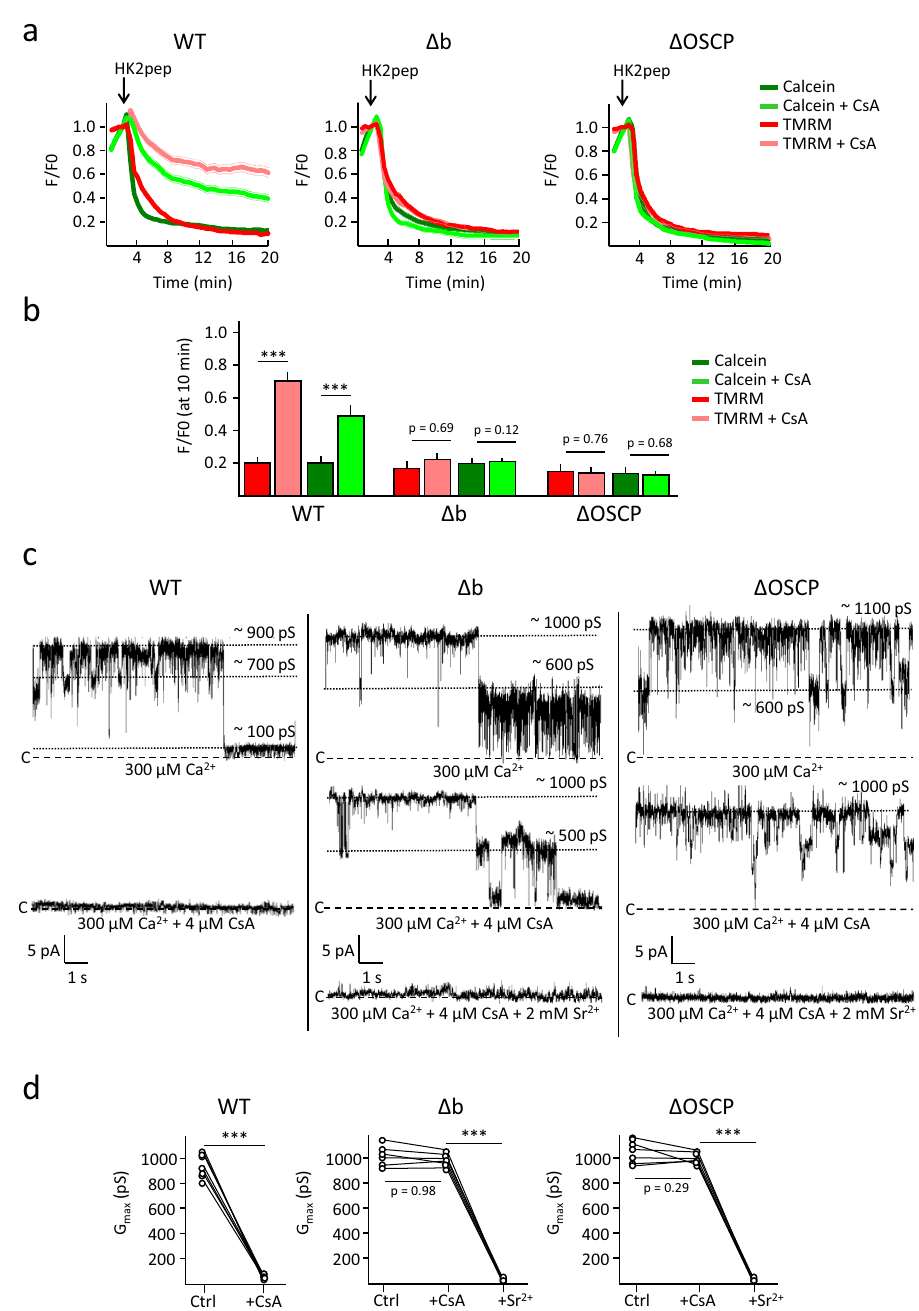
Fig. 3 The permeability transition in wild-type, Δ b, and Δ OSCP HAP1 cells. a Changes in mitochondrial calcein (green traces) and TMRM (red traces) fl uorescence intensities in the absence (dark colors) or presence (light colors) of 4 µ M CsA. Where indicated, 15 µ M HK2 peptide (pep) was added. Left panel, WT HAP1 cells; middle panel HAP1- Δ b cells; right panel, HAP1- Δ OSCP cells. Data are averages of the following ROIs over four independent experiments for each condition and genotype: for WT, 130 (HK2) and 171 (HK2 + CsA); for Δ b, 146 (HK2) and 168 (HK2 + CsA); and for Δ OSCP 173 (HK2) and 137 (HK2 + CsA); SEM for each time point is denoted by thin lines. b Analysis of the calcein and TMRM fl uorescence intensities 8 min after peptide addition in the absence (dark colors) or presence (light colors) of 4 µ M CsA. Data are average ± SEM of the ROIs indicated above, *** p < 0.001, ** p < 0.01, two-sided Student ’ s t -test. c PTP channel activity obtained by patch-clamping isolated mitoplast from WT HAP1 cells (left panel), HAP1- Δ b cells (middle panel), and HAP1- Δ OSCP cells (right panel). Where indicated, 4 µ M CsA and 2 mM Sr 2 + were added. Currents in WT cells were recorded in seven experiments out of 11; currents in Δ b cells were recorded in seven experiments out of 25; currents in Δ OSCP cells were recorded in eight experiments out of 25. d Analysis of the maximal conductance ( G max ) calculated in each independent experiment before and after the addition of 4 µ M CsA or 2 mM Sr 2 + . *** p < 0.001, ** p < 0.01, two-sided paired t